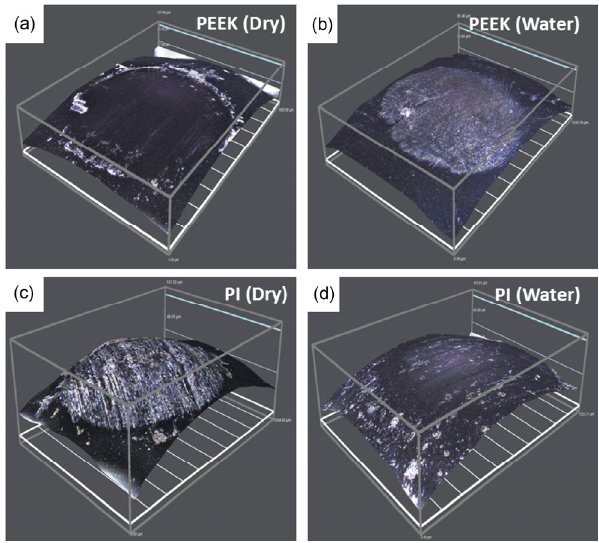
Fig. 13 Optical micrographs of Si 3 N 4 ball sliding against PEEK